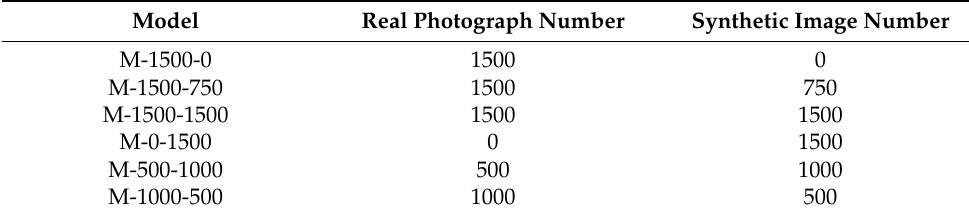
Table 2. Training dataset configuration. Model Real Photograph